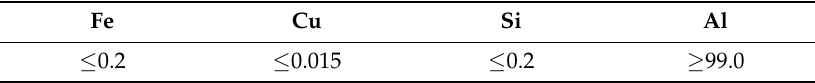
Table 1. Chemical composition of aluminum powder (weight fraction: